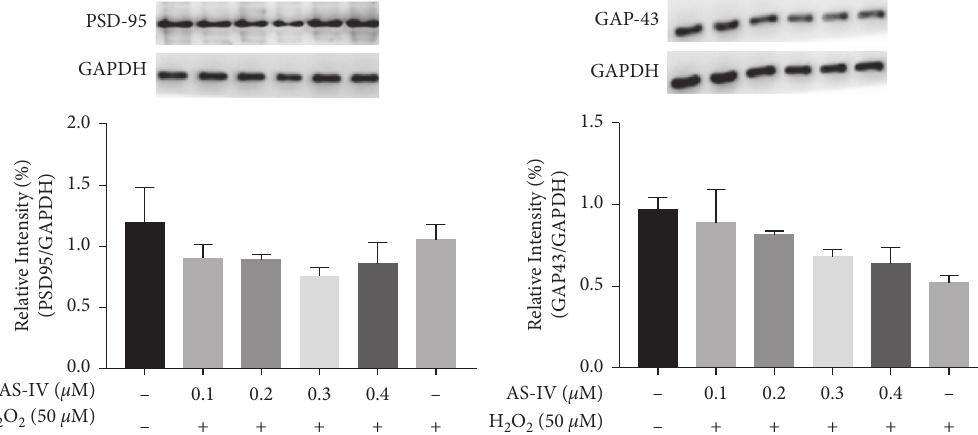
Figure 3: Protein expression of PSD-95 and GAP-43 in SH-SY5Y cells under stress conditions. (a) Expression of PSD-95 under H (50 μ mol · L − 1 ) treatment for 3 h after AS-IV (0.1 ∼ 0.4 μ mol · L − 1 ) pretreatment for 2h. (b) Expression of GAP-43 under H 2 O 2 (50 μ molL − 1 ) treatment 3h after AS-IV (0.1 ∼ 0.4 μ molL − 1 ) pretreatment for 2h untreated, and H 2 O 2 -treatment cells were used as blank and negative controls,